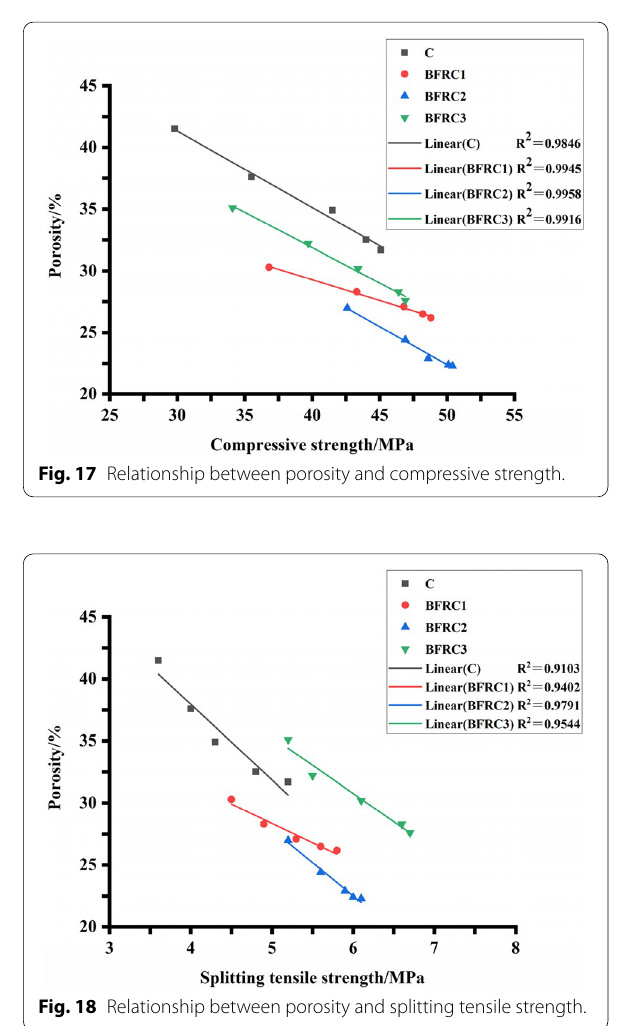
Fig. 20 Relationship between pore size distribution and compressive strength